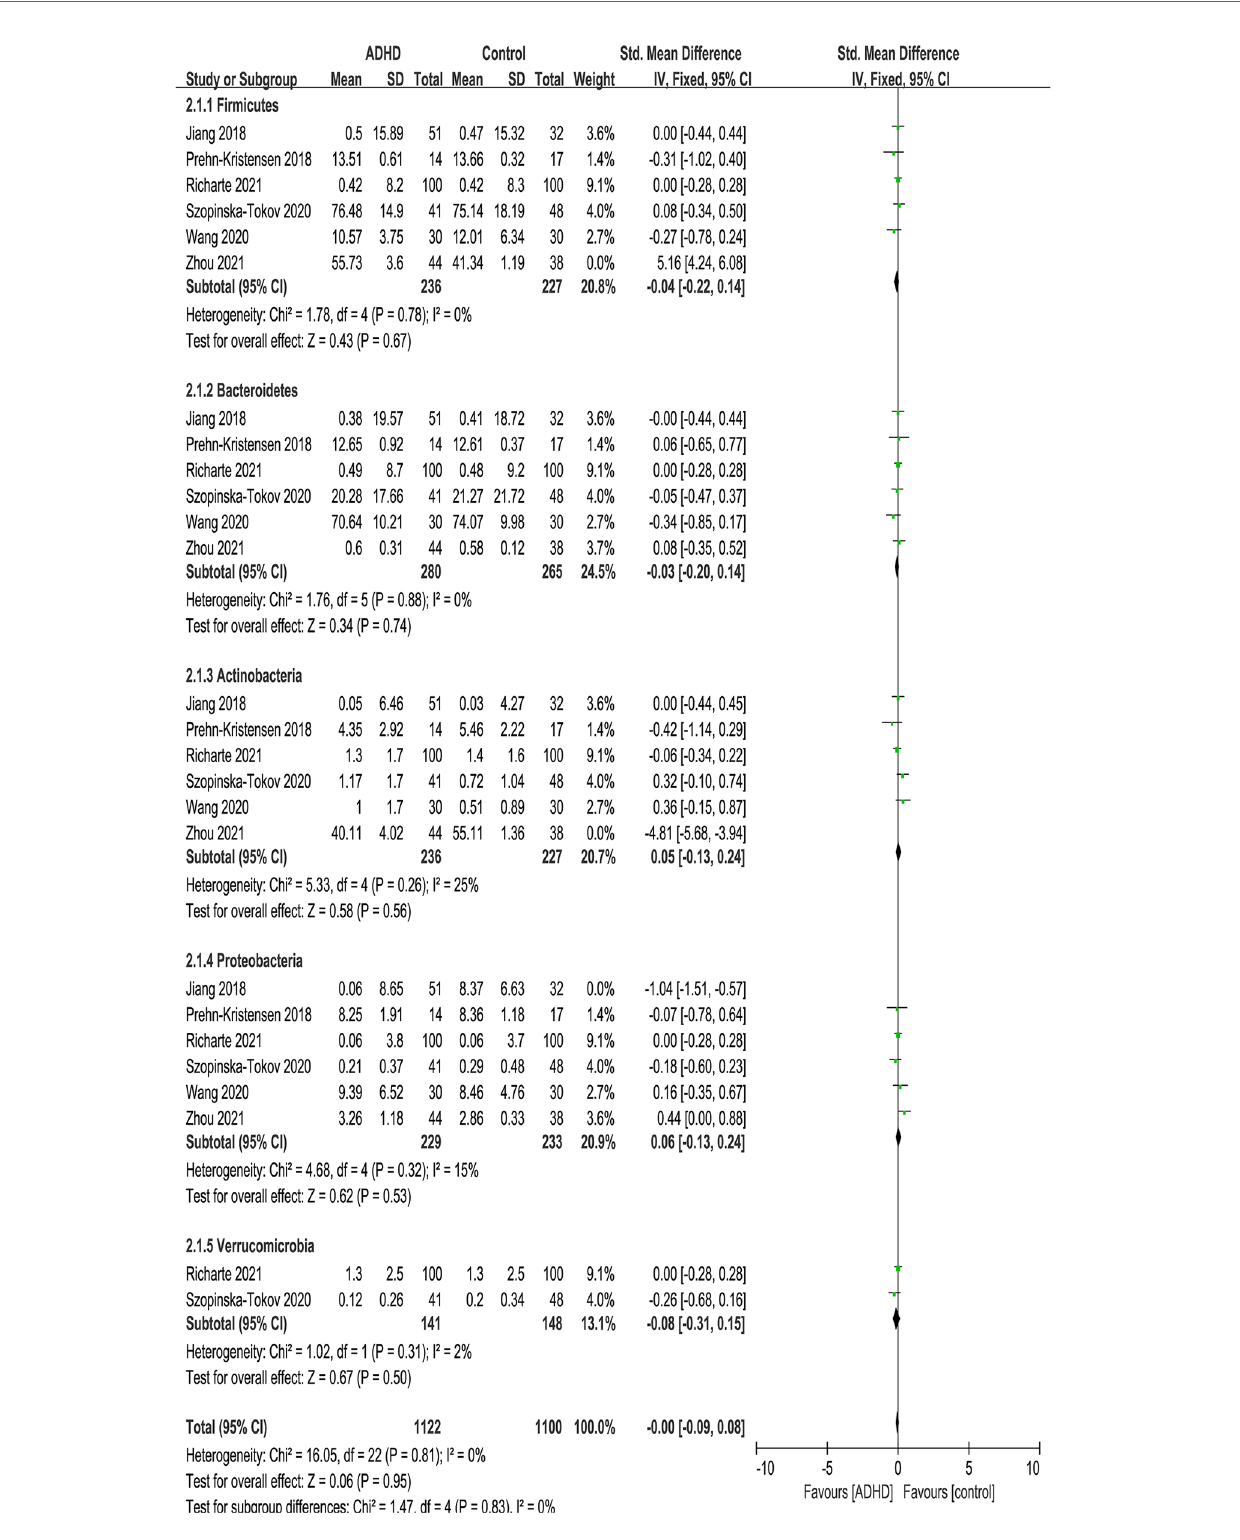
FIGURE 6 | Sensitivity analysis after removing heterogeneous studies of relative abundance of Phylum in the Gut Microbiota of ADHD Compared with HCs. CI, con fi dence interval; SMD, standardized mean difference.